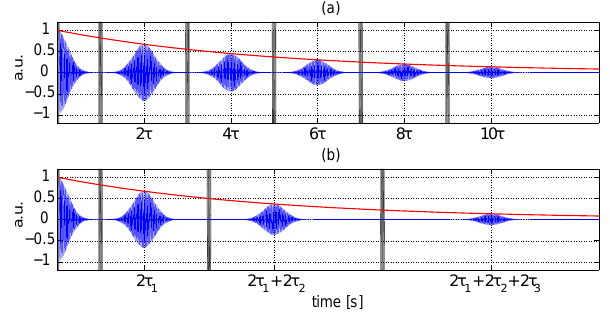
Fig. 2. (a) Classical CPMG sequence with a P90 excitation pulse and several P180 pulses for refocusing. After each P180 pulse an echos appears. The envelope of all detected echos gives the T 2 decay curve. (b) First pulses and the resulting echos for a CPMG sequence with variable τ